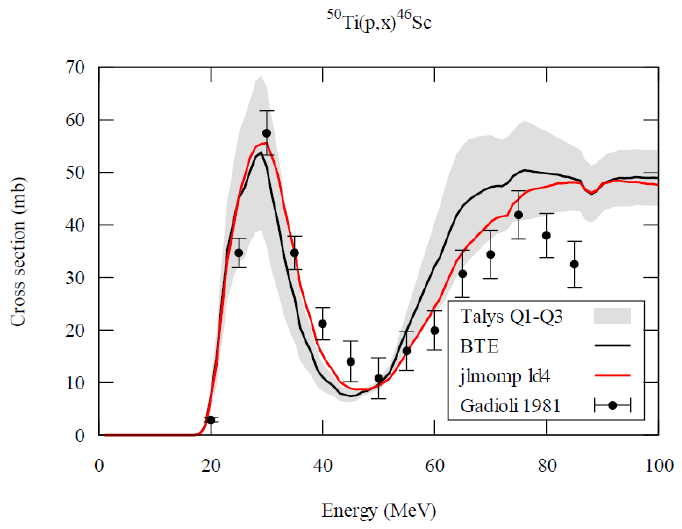
Fig. 3. Experimental and theoretical cross sections for the reaction 50 Ti(p,x) 46 Sc. The Talys modified curve (red line) refers to the ld4 option combined with semi microscopic optical potential JLM. The interquartile band and the BTE curve (black line) refer to a statistical analysis of the standard Talys